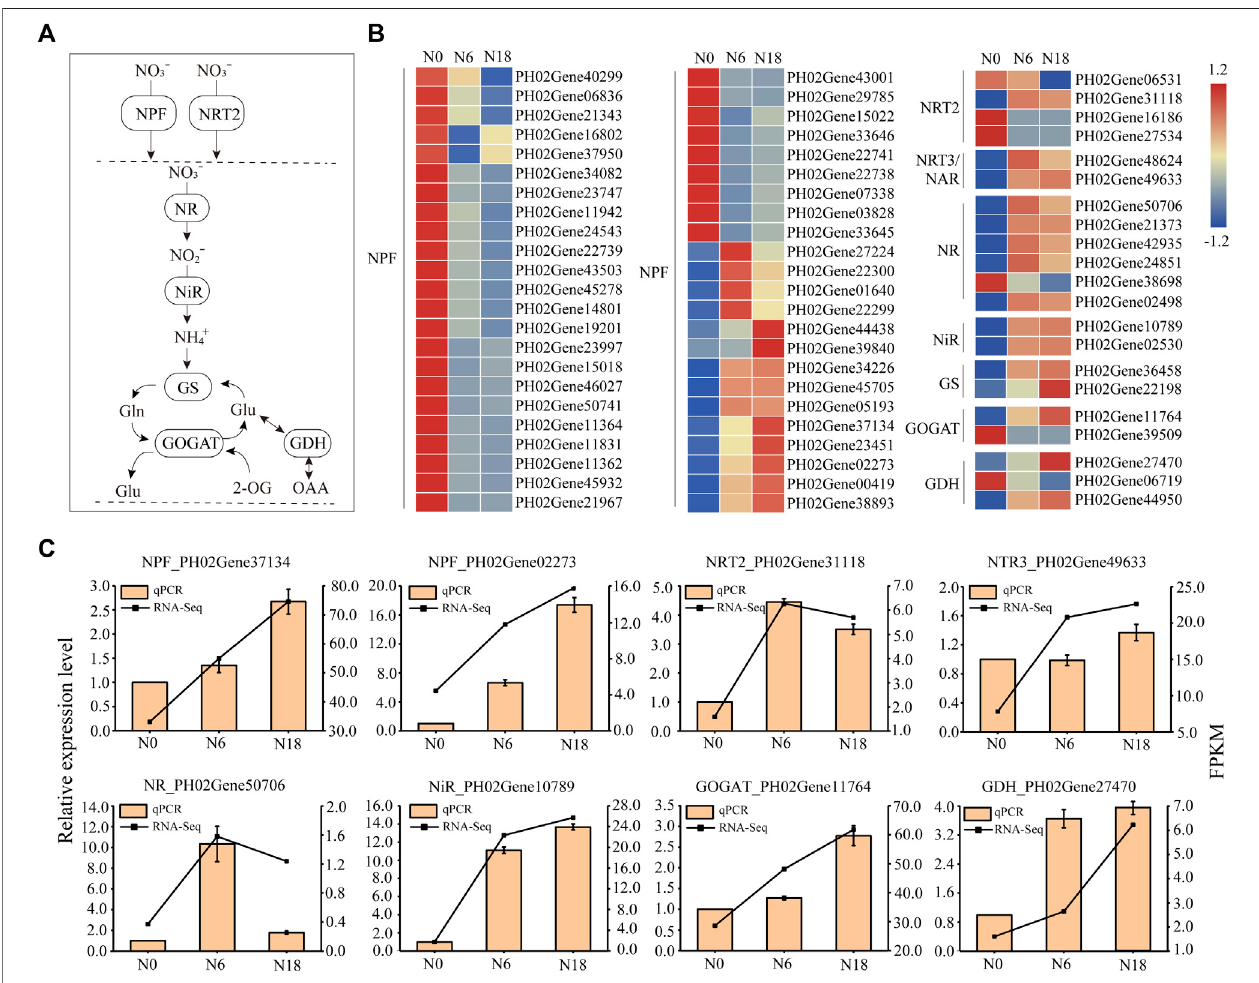
FIGURE 3| Expression pro fi les ofgenes involved in nitrogen metabolism ofbamboo roots: (A) outlineof nitrate uptakeand assimilation; (B) heat map visualization of DEG expression pro fi les; (C) expression analysis of eight DEGs belonging to the NPF, NRT2, NRT3, NR, NiR, GOGAT, and GDH families. Expression pro fi les of TFs that participated in nitrogen